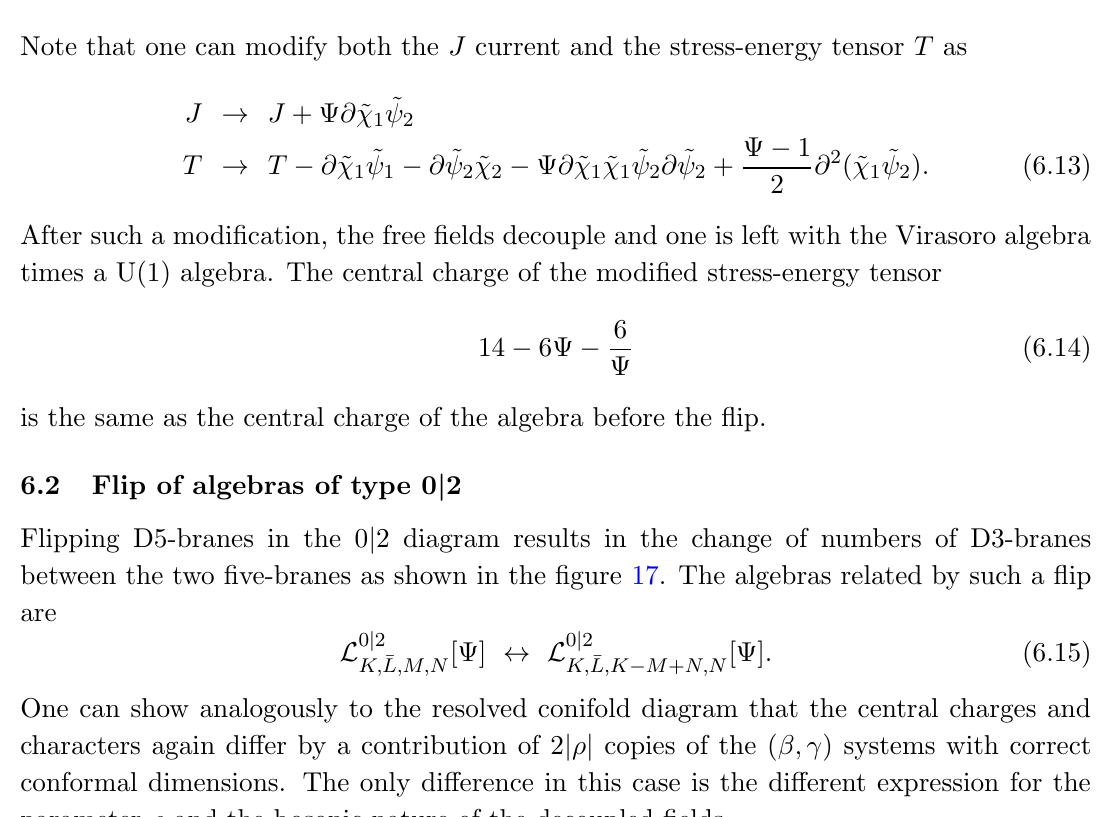
Figure 17. Flip transition for type 0 j 2 algebras in the case of K (cid:21) M (cid:21) N . A (cid:12)xed number of D3-branes is attached to each D5-brane. The crossing of D5-branes acts non-trivially on the number of D3-branes at the internal